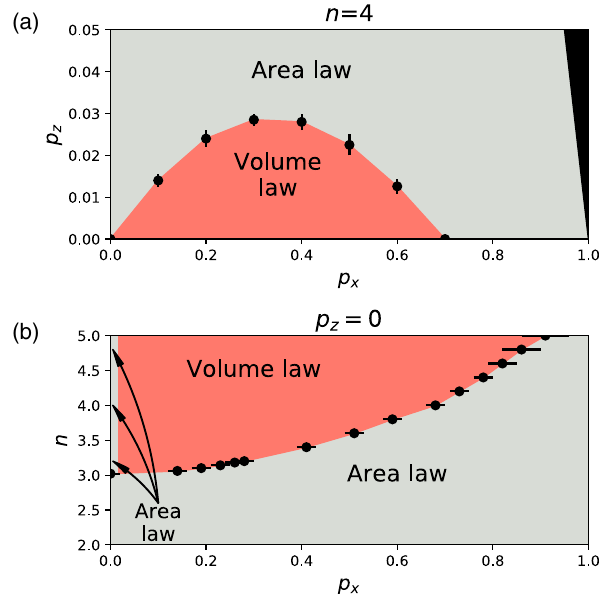
FIG. 3. (a) Rules for taking CZ and P gates past single-site X FIG. 2. Entanglement phase diagram of the l -bit unitary- measurements [Eq. (3)]. (b) The l -bit circuit from Fig. 1 after projective dynamics as a function of range n and probabilities taking all the gates past the measurements. Each single-site X p , p of projective measurements in the X and Z basis. The black x z measurement develops tails of Z operators on either side of dots represent crossings in the tripartite mutual information (see maximum length n − 1 (2 in this case) due to conjugation by CZ Sec. IV C) obtained from numerical stabilizer simulations of gates. (c) Sketch of general measurement-only dynamics. Multi- systems of L ≤ 512 qubits evolved for time T ¼ 4 L , averaged site Pauli measurements (ellipses) are equivalent to single-site over at least 100 random realizations. (a) Fixed range n ¼ 4 . For measurements conjugated by a unitary gate U 0 < p ≲ 0 . 7 , there is a volume-law phase robust to the intro- x duction of sufficiently infrequent Z measurements. (b) Measure- 0 ). Avolume-law phase exists for ments in the X basis only ( p z ¼ range n ≳ 3 . 05 (see Appendix A for the continuation of the 0 line is always area law, models to fractional range n ). The p x ¼ regardless of n .